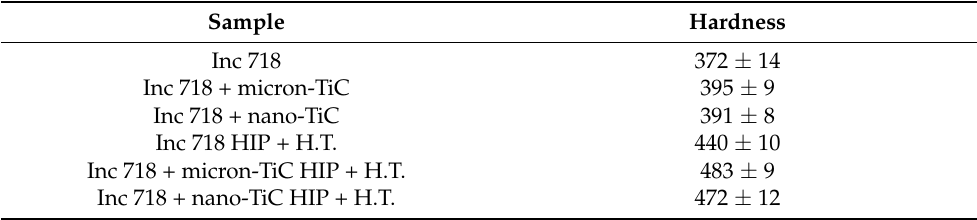
Table 6. Hardness of the samples (HV 10